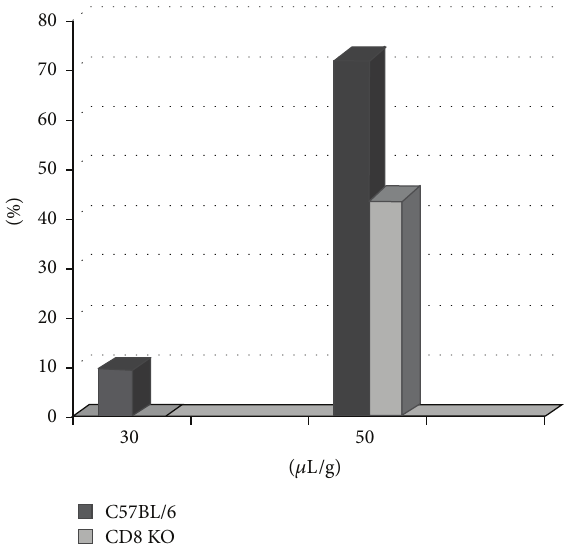
Figure 2: Incidence of disease in KO mice and control-C57BL/6 mice in passive transfer model of IgG PV. With a dose of 30 𝜇 L/g PV plasma, 0% (0/5) of the CD8 − / − mice developed PV, compared with 9.5% (4/42) of C57BL/6 mice. With an injected dose of 50 𝜇 L/g, 44% (13/29) of the CD8 − / − mice showed PV lesions, compared with 72% (26/36) of the control